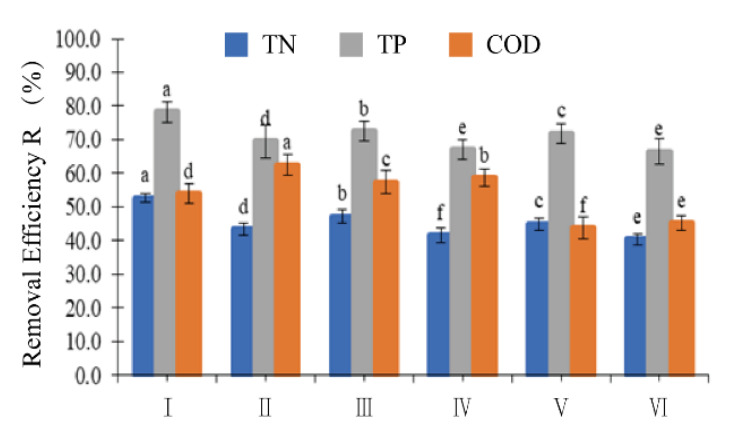
Figure 5. The removal efficiency R of TN, TP and COD by 6 plant material groups. The letters a–e indicate multiple significant difference